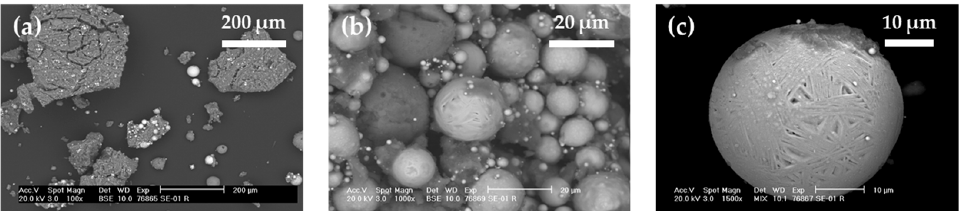
Figure 9. SEM images of SE_01-MT sample used for EDX analysis: ( a ) graphite particles with enclosed metallic spheres, ( b ) spherical debris of steel and aluminum alloy with lots of (sub-micron) agglomerates, ( c ) spherical particle with carbon contamination on surface, lamellar structure.